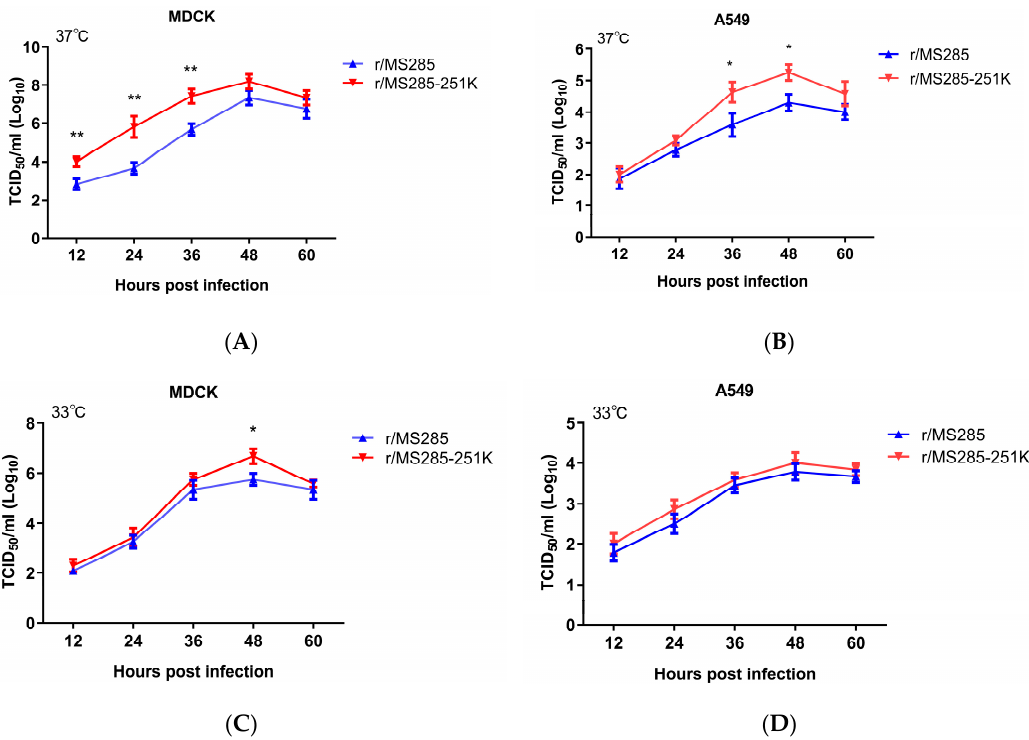
Figure 4. Growth kinetics of r/MS285 and r/MS285-251K viruses in MDCK and A549 cells. MDCK cells were infected at an multiplicity of infection (MOI) of 0.01 with r/MS285 and r/MS285-251K viruses and cultured at 37 °C ( A ) or 33 °C ( C ). A549 cells were infected at an MOI of 0.01 with r/MS285 and r/MS285-251K viruses and cultured at 37 °C ( B ) and 33 °C ( D ). Culture supernatants were harvested at 12, 24, 36, 48, and 60 hpi and subjected to TCID 50 assay in MDCK cells. The results are expressed as the means ± SD ( n = 3) and the statistical significance was calculated using one-way ANOVA. *, p < 0.05; **, p < 0.01.